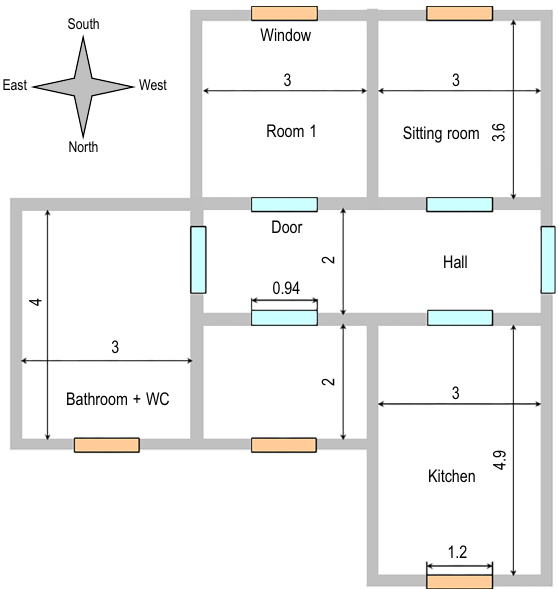
Fig. 2. Descriptive plane: southern